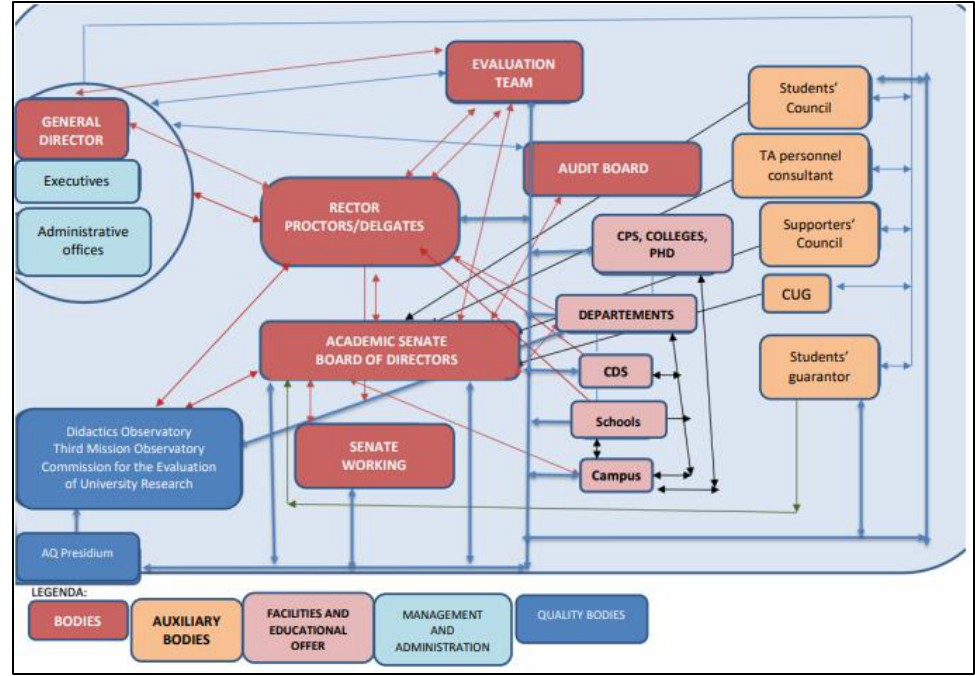
Figure 1. University of Bologna overview.